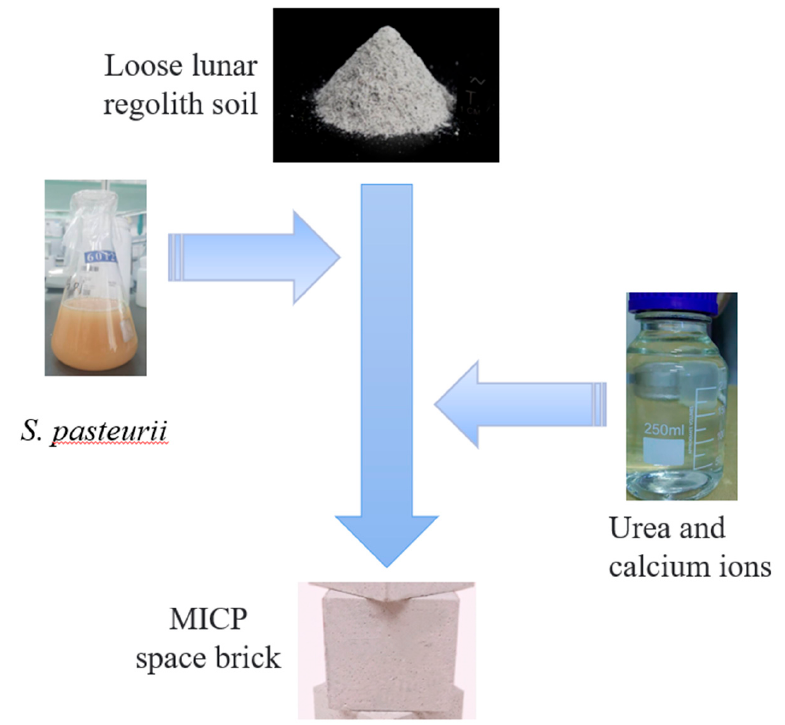
Figure 8. Preparation processes of MICP space brick.